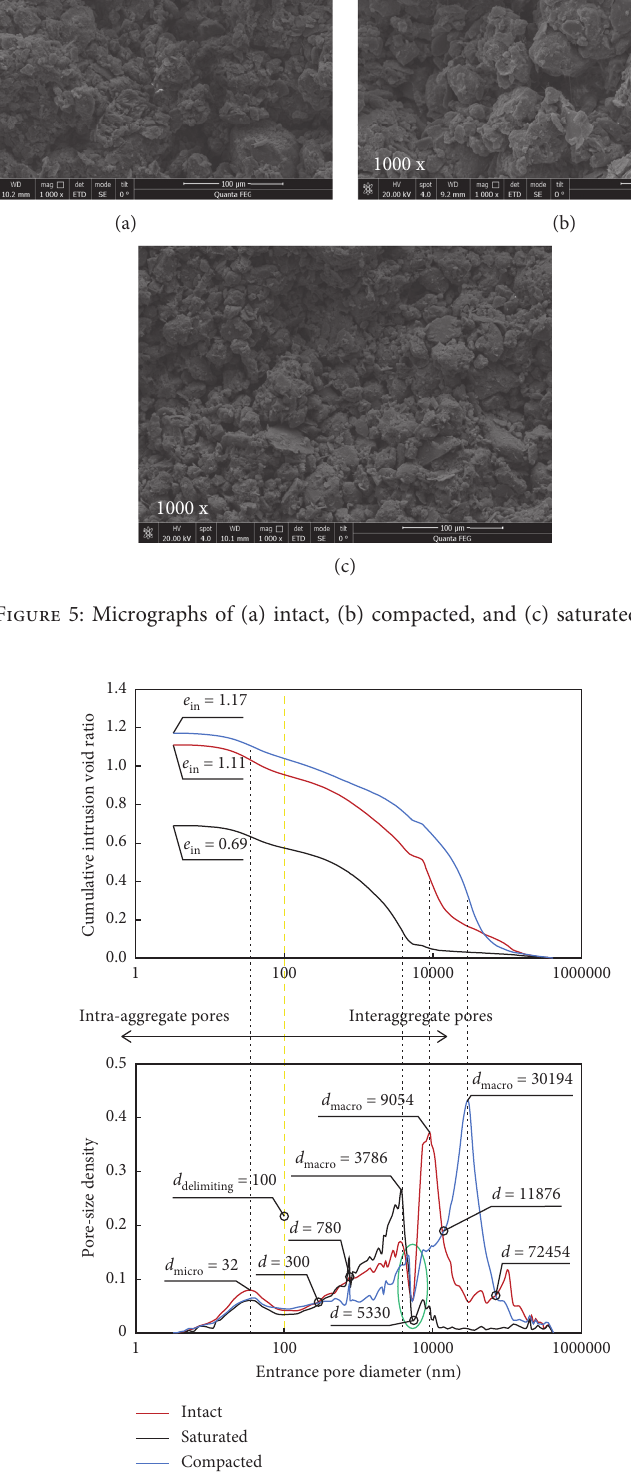
Figure 6: PSDs of intact, compacted, and saturated loess